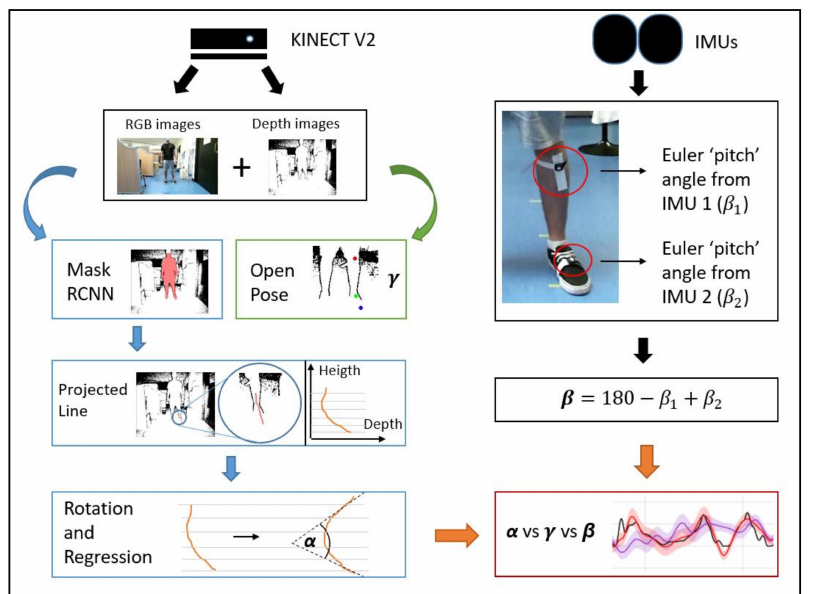
Figure 3. Scheme of the methods used to calculate the ankle angle using the Kinect v2 device with a region-based convolutional neural network (RCNN Mask) and OpenPose on the one hand, and two Inertial Measurement Units on the other.